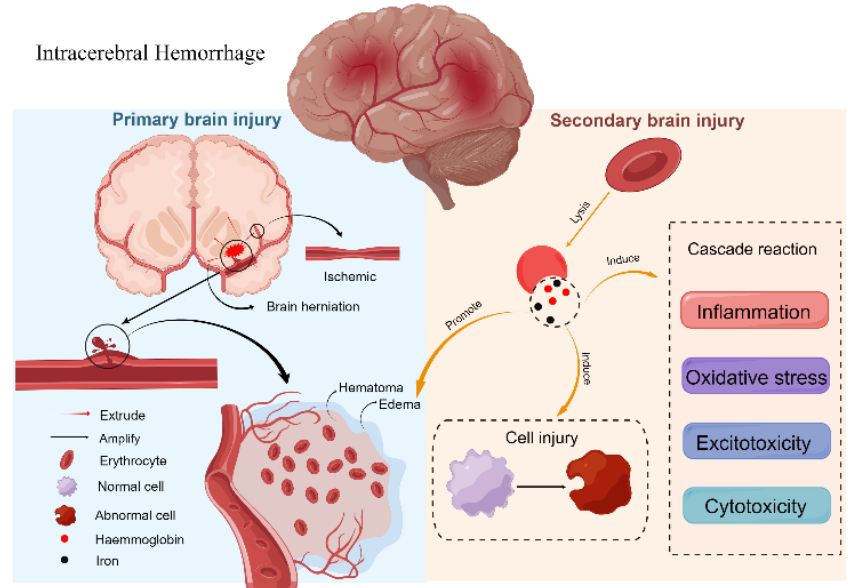
Figure 1. Mechanisms following intracerebral hemorrhage (figure made by Figdraw).